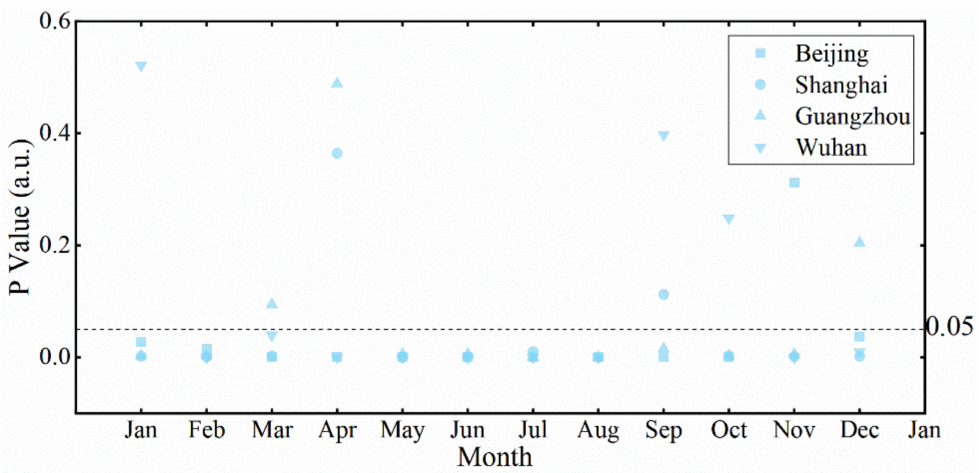
Figure 4. Calculated P values of each month in the study area by using the Kruskal–Wallis